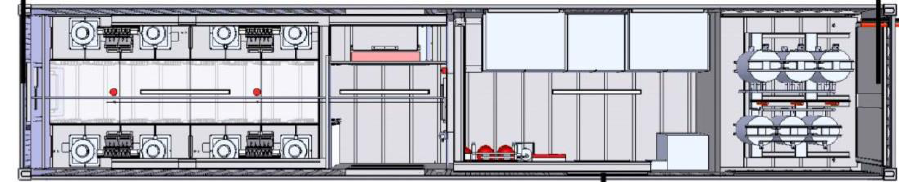
Figure 2. Construction of a 1 MW lithium-ion battery system for grid applications [49].